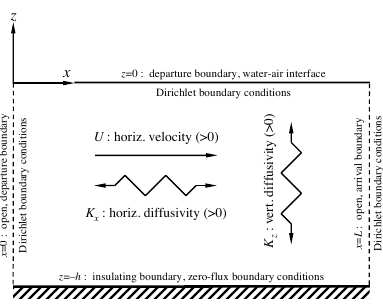
Figure 9. Schematic representation of the two-dimensional, “horizontal-vertical” domain of interest for the simple ventilation study dealt with in Section 4. The nature of the boundaries and the related boundary conditions are also